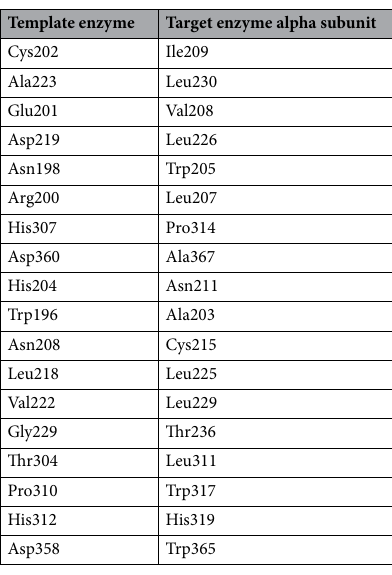
Table 1. Structural comparison of the major amino acid residues around the active sites of the template 4QUR and target enzyme alpha subunit.